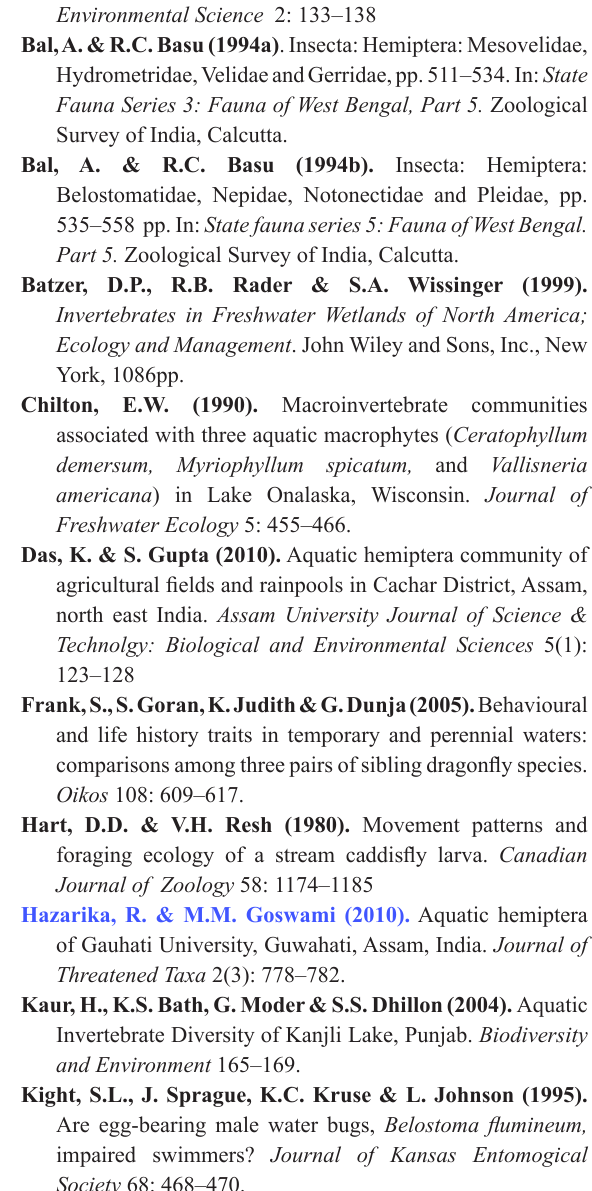
Figure 3. Temporal fluctuation of percentage relative abundance of different species of insects around Phumdi Live (PL) and Phumdi Mixed (PM) area. Ra - Ranatra varipes , La - Laccotrephes ruber , Ge - Gerris sp., Di - Diplonychus rusticus, Tr - Tramea sp., Le - Leucorrhinia sp., Sy - Sympetrum